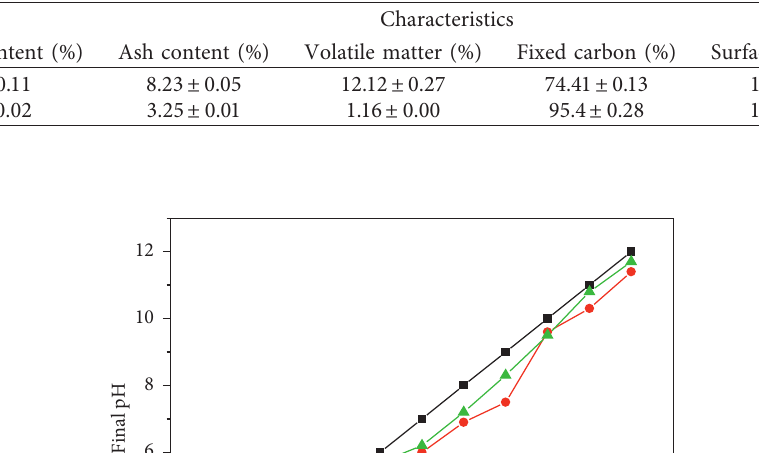
Table 1: Proximate analyses of the adsorbents.